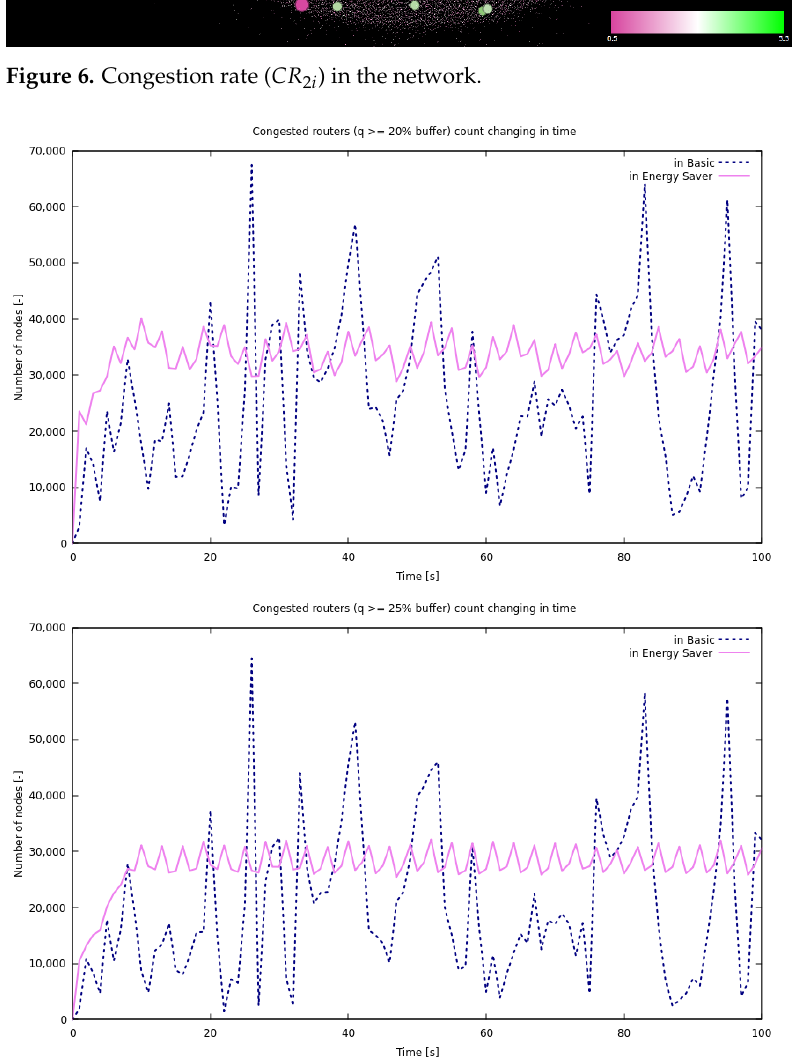
Figure 7. The number of routers having current queue lengths greater than 20% and 25% of their buffer sizes in basic and energy-saving